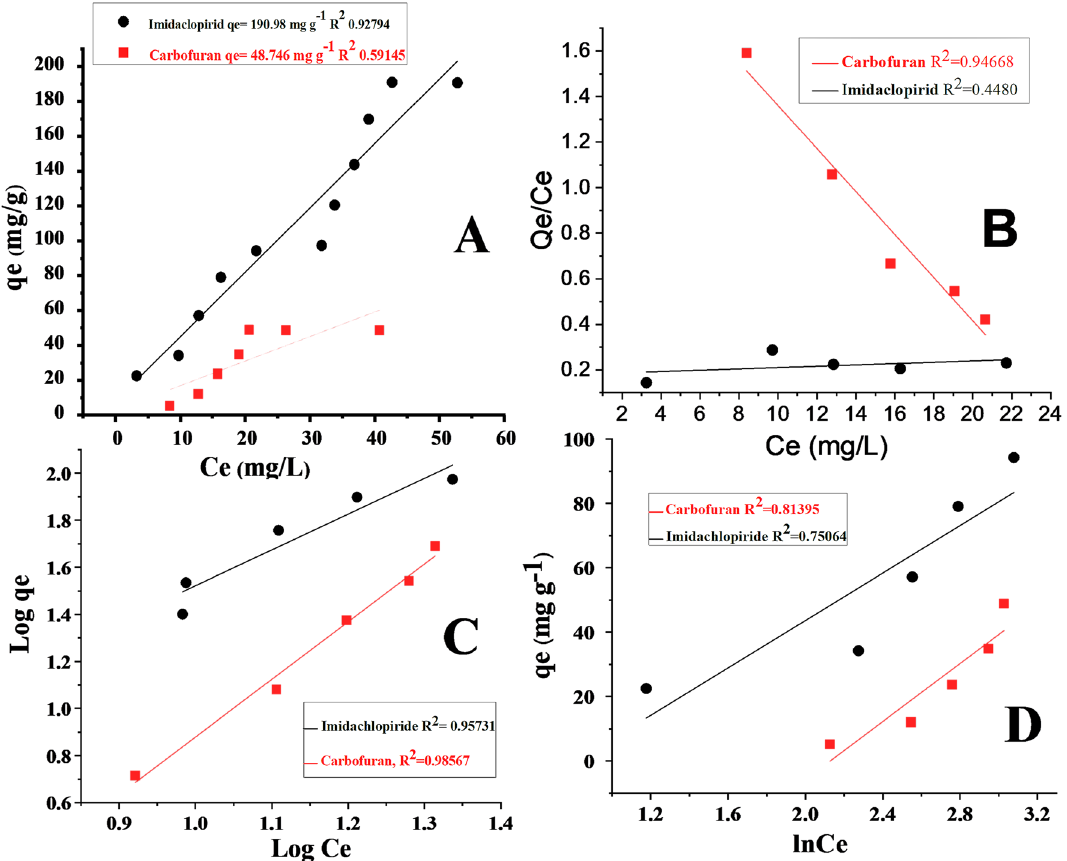
Figure 8. ( A ): General adsorption isotherm ( B ): Langmuir adsorption isotherm ( C ): Freundlich adsorption isotherm ( D ): Temkin adsorption isotherm for the adsorption of carbofuran and